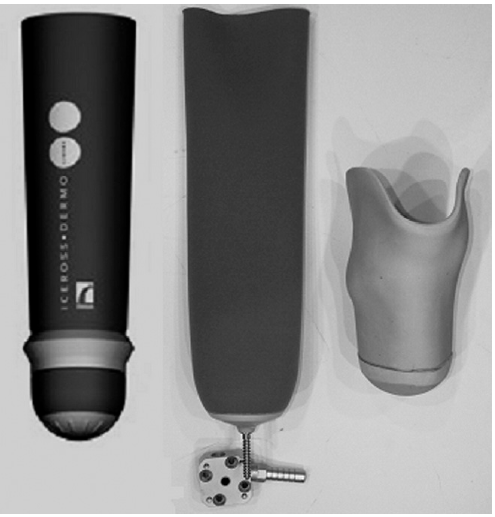
Figure 9. Three different liners, ( Left ) seal-in silicone liner; ( Middle ) pin/lock silicone liner; and ( Right ) Pelite liner [151].